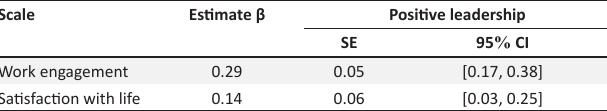
TABLE 5: Indirect Effects of Positive Leadership and Psychological